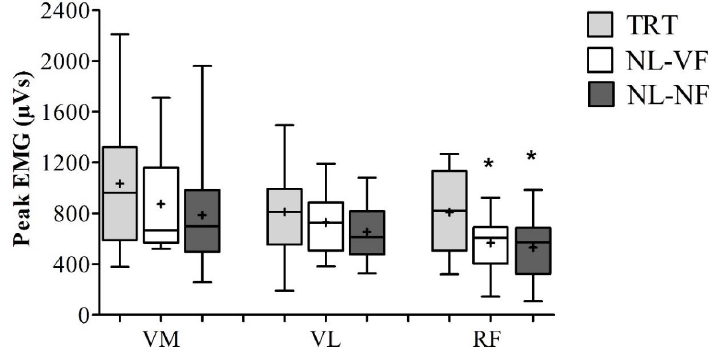
Figure 3. Comparison of peak EMG activity between trainings. TRT = traditional resistance training; NL-VF = no-load training with visual feedback; NL-NF = no load training without visual feedback; VM = vastus medialis; VL = vastus lateralis; RF = rectus femoris. Values are presented as median (lines) with interquartile range (boxes) ± range (minimum and maximum) and + indicates mean * p < 0.05 vs. TRT.